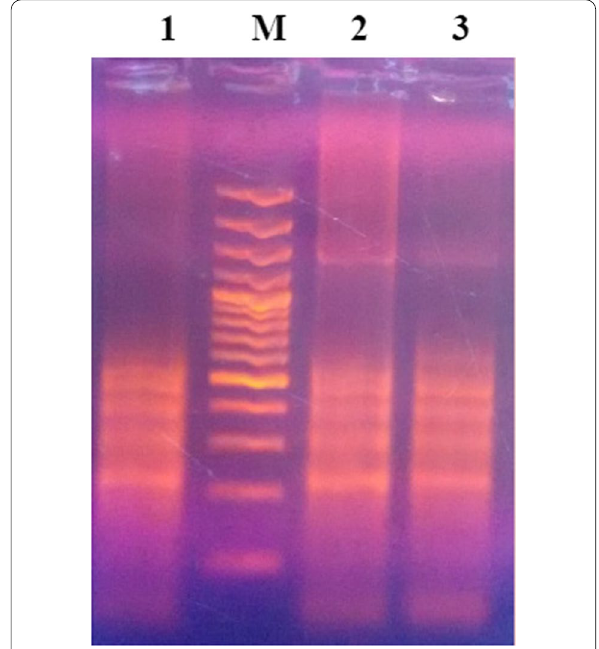
Fig. 3 LAMP-based amplification of ITS gene. Lane M: 100-bp DNA ladder. Lane 1: positive T. annulata DNA. Lanes 2–3: test samples